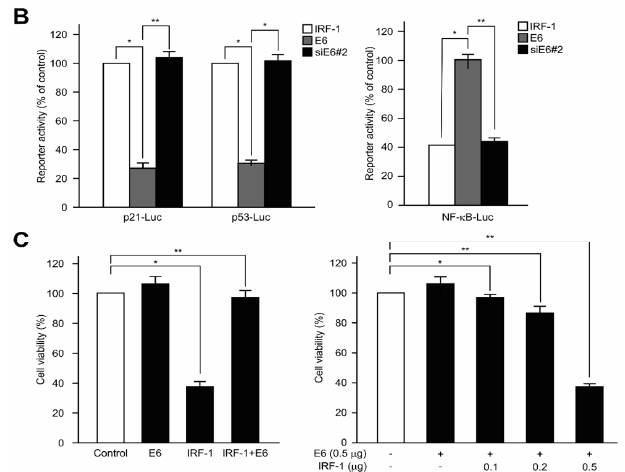
Figure 5. Effects of HPV16 E6 on IRF-1-induced apoptosis, p53, and nuclear factor kappa B (NF- κ B) activity. ( A ) CaSki cells were transfected with HPV16 E6 expression plasmid (pcDNA3.1/HPV16 E6) (left panel) and IRF-1 for 24 h, and IRF-1-expressing cells were then transiently transfected with a control, HPV16 E6 (middle panel) or siE6#2 (right panel), respectively. After 48 h, cells were harvested and treated with lysis buffer. Whole cell lysates were subsequently subjected to western blotting analysis. Protein expression of cell cycle and apoptosis-related genes was observed. Protein expression was visualized through immunoblotting using specific antibodies. All experiments were repeated at least three times with similar results. ( B ) Promoter activities of p21, p53, and NF- κ B were estimated via luciferase reporter-gene analysis with a p21 promoter reporter (p21-Luc), p53 (p53-Luc) and NF- κ B (NF- κ B-Luc), respectively. For instance, the p21-luciferase reporter gene constructs or promoter-less plasmid (vector only) were transfected into IRF-1-induced cervical tumour cells. Briefly, cells were incubated for 24 h and then added to the lysis buffer. After centrifugation, whole cells were lysed and mixed with luciferase reaction substrate to measure the luciferase activity. All results shown are representative of three independent experiments, and the bars indicate the mean ± SD. * p < 0.05; ** p < 0.01 compared with control group. ( C ) CaSki cells were transfected with HPV16 E6, IRF-1, or HPV16 E6 plus IRF-1, respectively. Relative rates of cell proliferation were evaluated as described in the manufacturer’s instructions provided for the CellTiter-Glo assay system. Results represent the mean ± SD of at least three independent experiments conducted in triplicate; * p < 0.05; ** p < 0.01 compared with control.